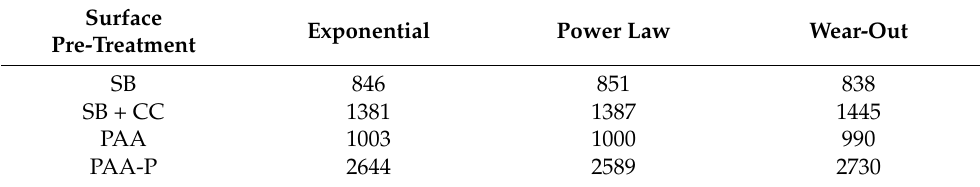
Table 1. Fatigue strength (N) of various specimens based on the three models at 10 5